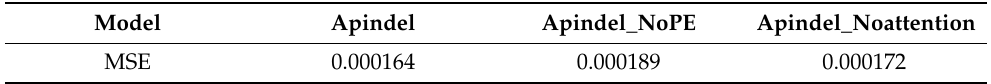
Table 3. Performance evaluation of pre-selected models, on the Lindel